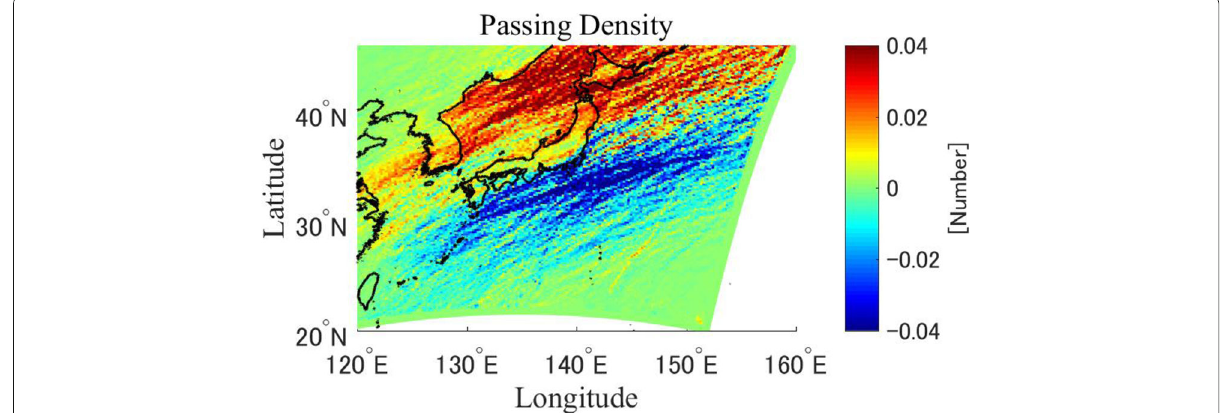
Fig. 11 Future changes in severe winter storm tracks around Japan, based on d4PDF-R (future minus past, unit: numbers per year in each 1°-longitude and 1°-latitude box), after Taka et al.